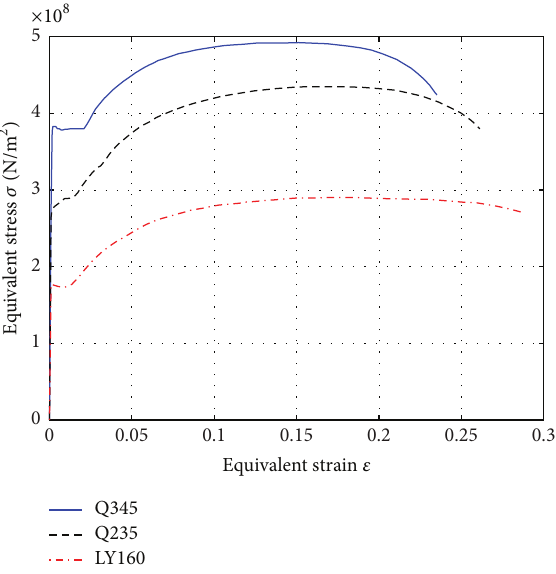
Figure 4: Stress-strain curve of different